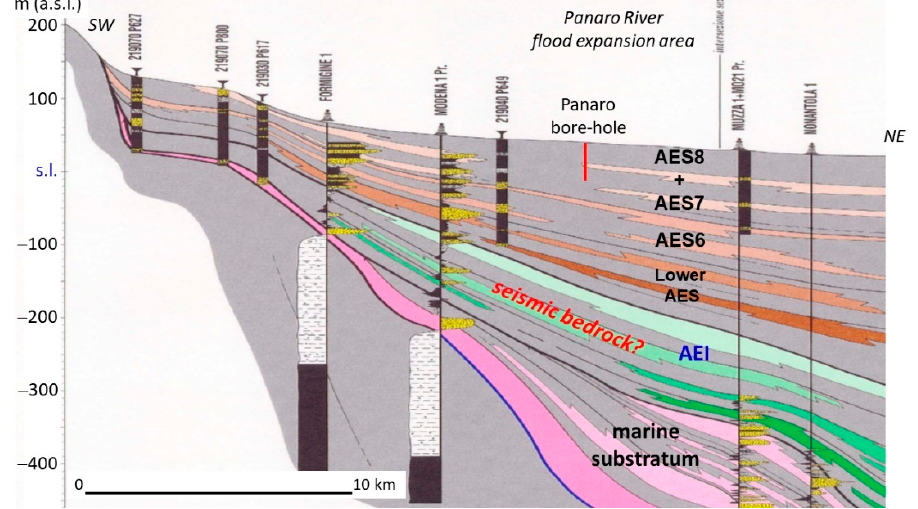
Figure 14. Geological cross-section across the Panaro River alluvial fan (modified from [11]).